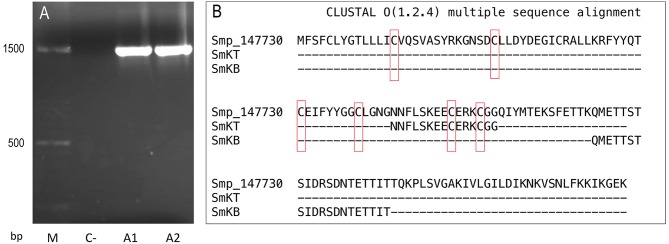
Sequences of Smp-147730 (Syn. Smp_311670) of S. mansoni: (A) Agarose gel electrophoresis insert of 1444 base pairs (bp) obtained by PCR from two adult DNA samples (A1 and A2) with negative control (C–) and molecular mass marker (M). (B) Amino acid sequence and alignment with Clustal Omega of predicted T-cell peptide (SmKT) and B-cell peptide (SmKB).